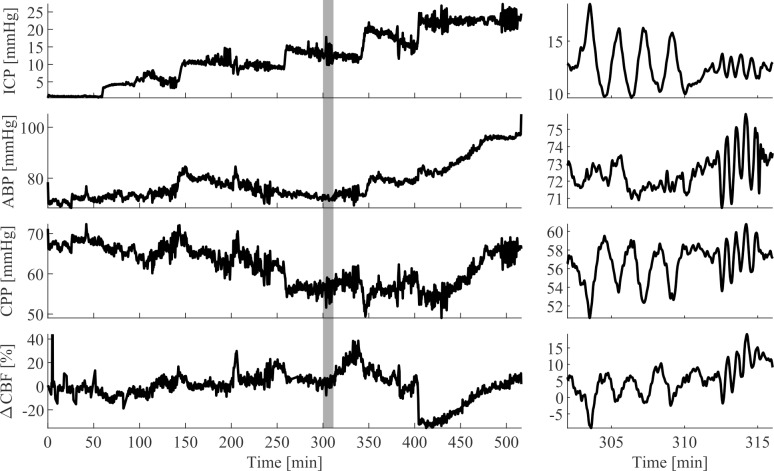
A representative measurement of one NHP under fentanyl anesthesia.The left side shows the entire time trace of this NHP. Clear steps in ICP are shown on the top graph. ABP follows the ICP baseline trend in the second graph from the top, keeping CPP in the third graph largely stable. CPP is defined as the difference between MAP and ICP. ΔCBF changes in the bottom graph show immediate reactions to baseline changes and recovery. The right-hand side shows a zoomed in frame around the minutes 300 to 317 (grey box on the left). Here it can be seen that ICP oscillations (until 310 minutes) as well as ABP oscillations (after 310 minutes) were translated into CPP and ΔCBF.